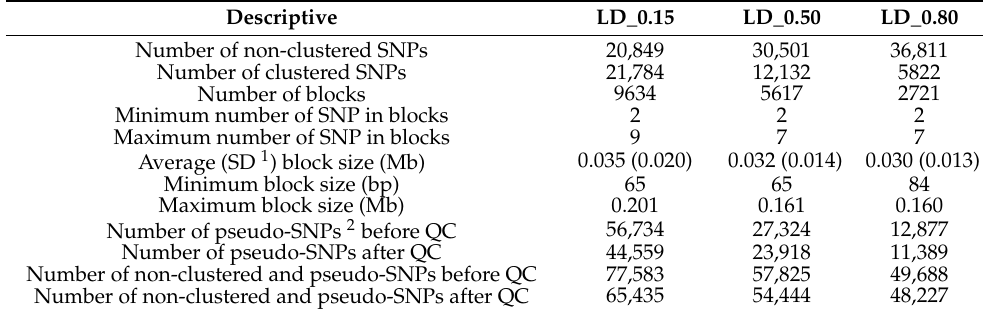
Table 2. Descriptive statistics of the haplotype blocks with different linkage disequilibrium (LD) thresholds used in each scenario, before and after quality control (QC), in American Angus